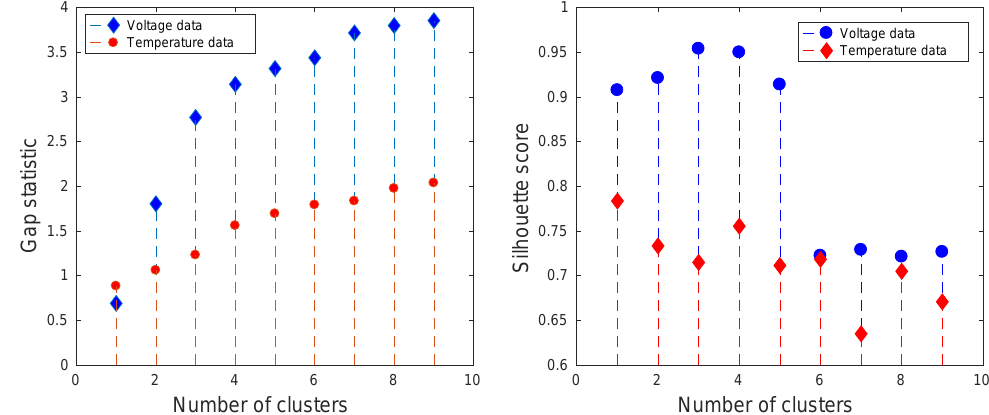
Figure 10. The gap statistic ( left ) and the silhouette score ( right ) of the obtained clustering solutions of reduced data that are measured during charging period.